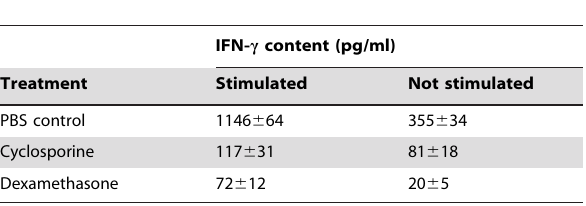
Table 1. Levels of interferon (IFN)- c secreted by murine splenocytes following treatments with dexamethasone or cyclosporine.